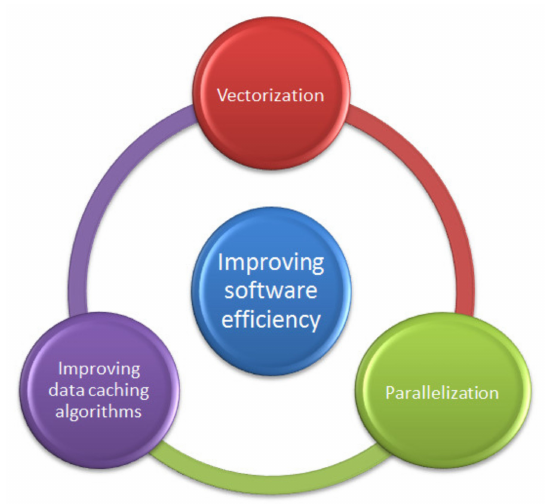
Figure 1. The main directions of increasing the software efficiency for target computing